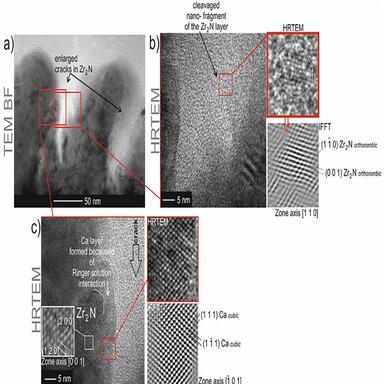
Pitting corrosion mechanism of the Zr/Zr2N (1:4 ratio) multilayer coatingwith a-C:H top-layer coating demonstrated by using an HRTEM image; a). TEM BF image showing the enlarged cracks in Zr2N layer; b). HRTEM image showing cleavaged nano-fragments of the Zr2N layer; c). HRTEM image showing formation of Ca layer in Zr2N cracks as a remain of the Ringer solution interaction.